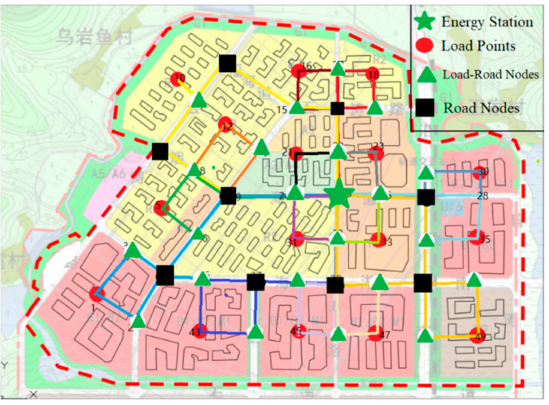
Figure 8. Connected graph G of the study area using the Energy Station-to-Load Points model.